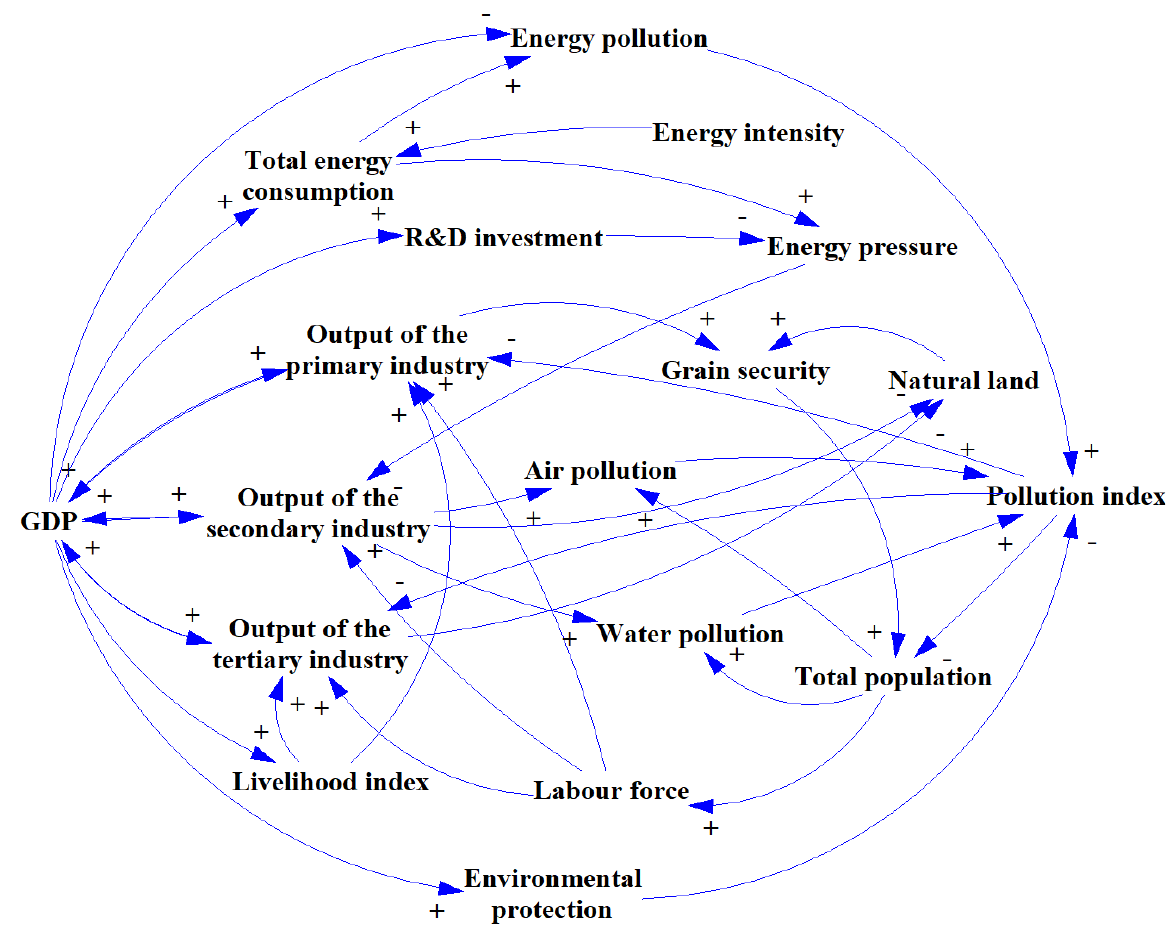
Figure 1. Causal loop diagram of the urban system.